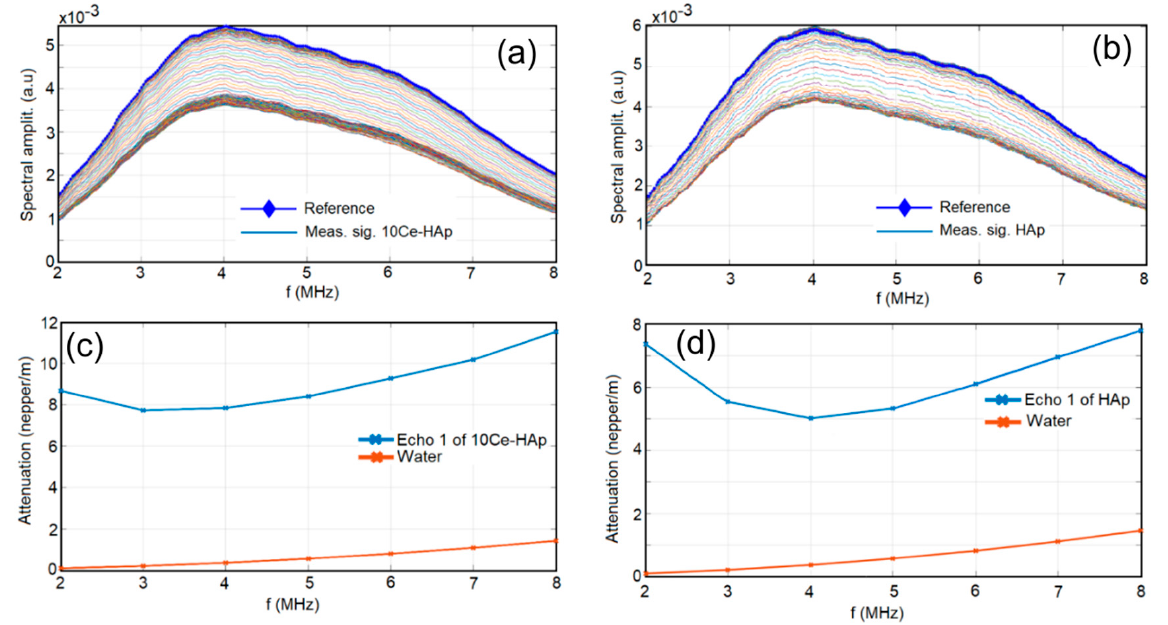
Figure 1. Frequency spectrum of the first transmitted echo of 10Ce-HAp ( a ) and HAp ( c ); Attenuation dependency of frequency for 10Ce-HAp ( b ) and HAp ( d ). 10Ce-HAp: cerium-doped hydroxyapatite (Ca 10 − x Ce x (PO 4 ) 6 (OH) 2 with x Ce = 0.1; Hap: hydroxyapatite.